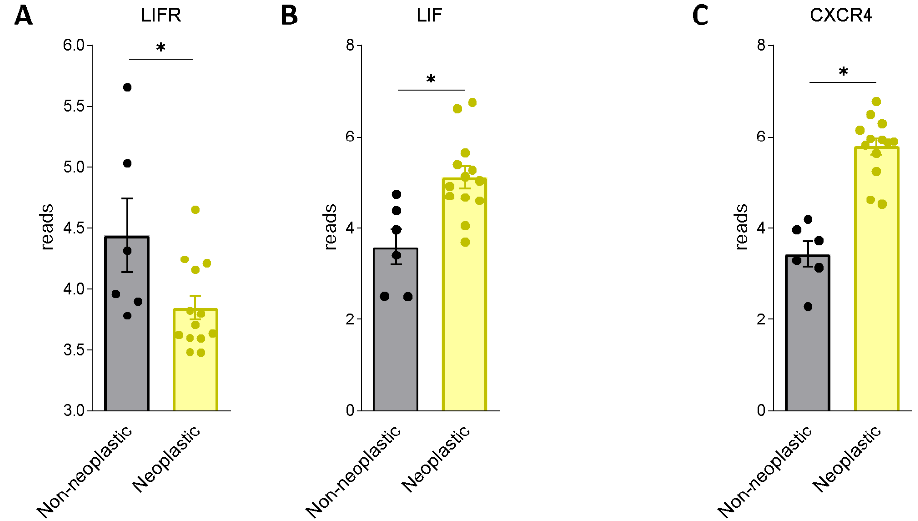
Figure 1. LIF and LIFR show an opposite regulation in human PDAC. RNA-seq analysis of non- neoplastic and neoplastic mucosa of PDAC from GSE196009 repository. Each dot represents a patient. Data shown represent the gene profile expression of ( A ) LIFR, ( B ) LIF, chemokine receptor type 4 ( C ) CXCR4. Results are the mean ± SEM of 6 (Non-neoplastic) and 13 (Neoplastic) samples per group. * p < 0.05.